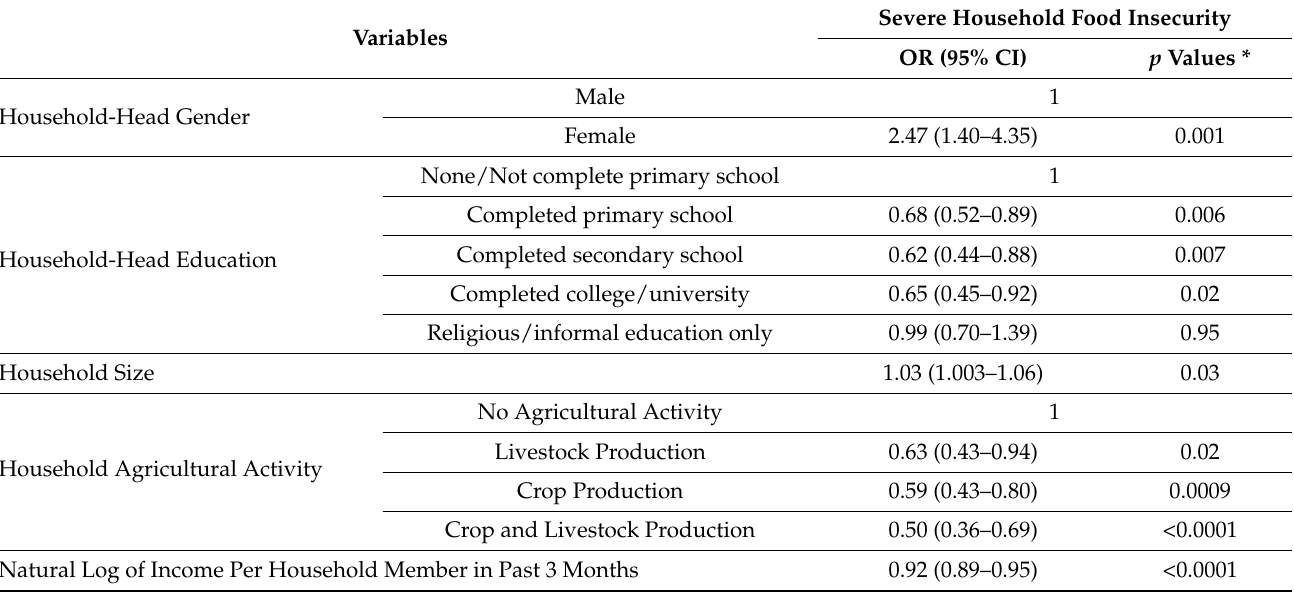
Table 4. Multivariate analysis of social determinants of severe household food